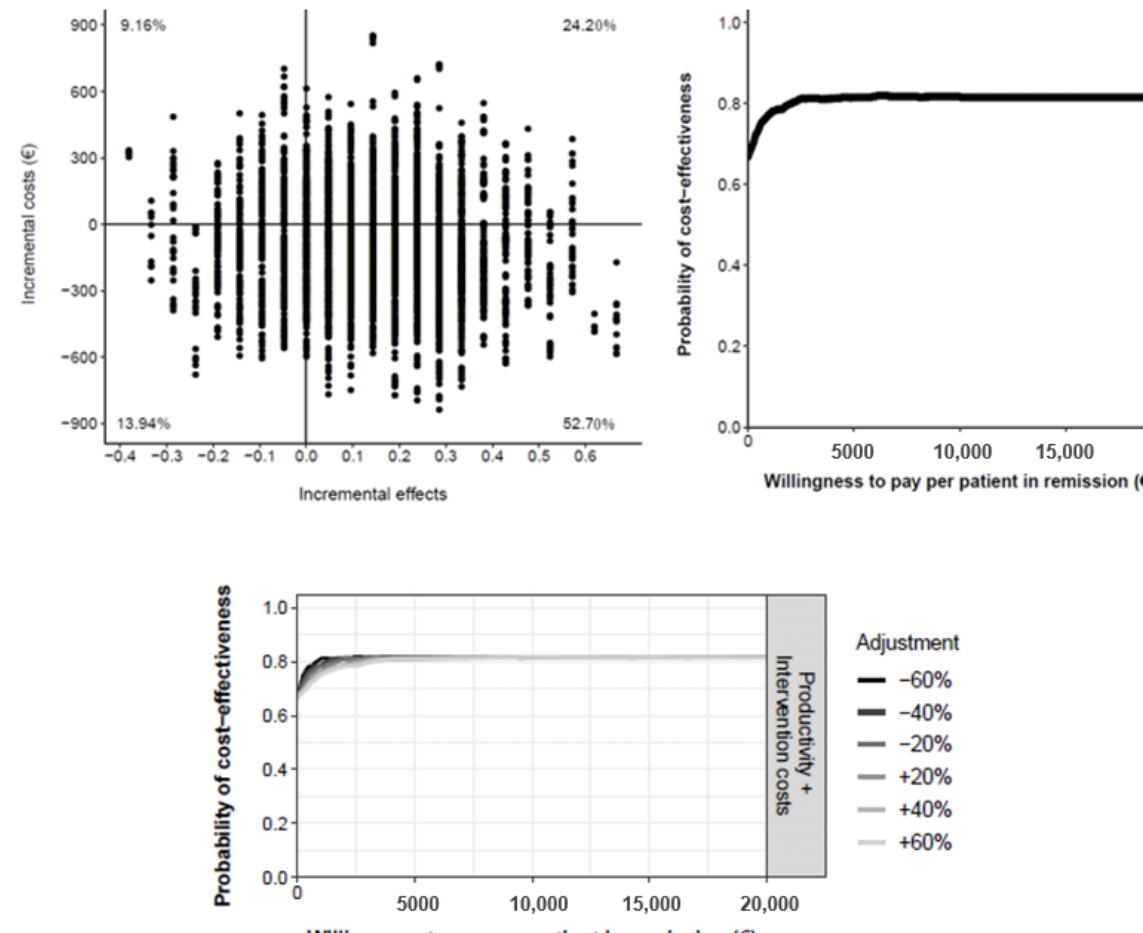
Figure 5. Cost-effectiveness plane (top left) and cost-effectiveness acceptability curve (top right) comparing telephone care versus standard care. Bottom: impact of different cost values on the cost-effectiveness acceptability